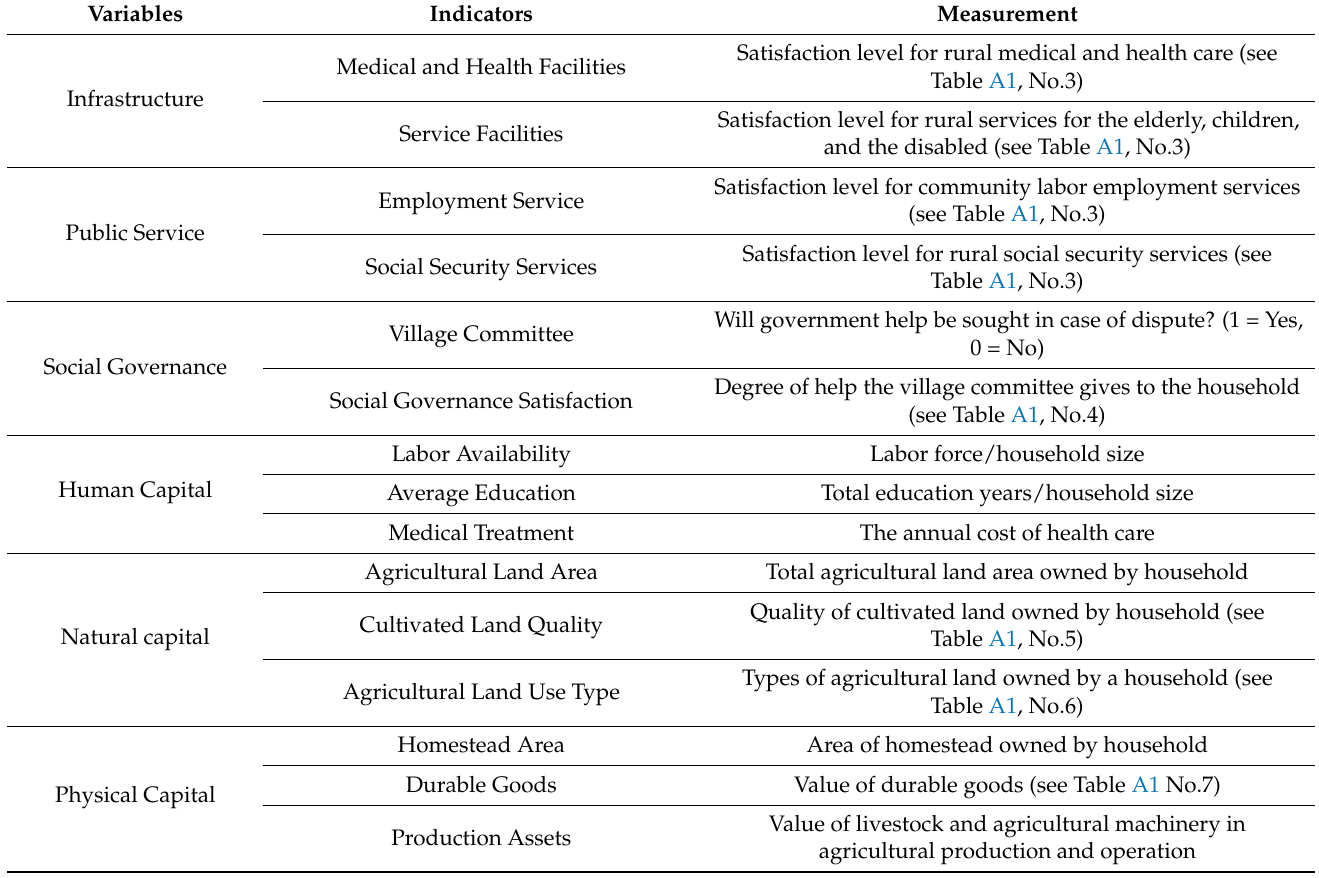
Table 2. Explanatory variables and